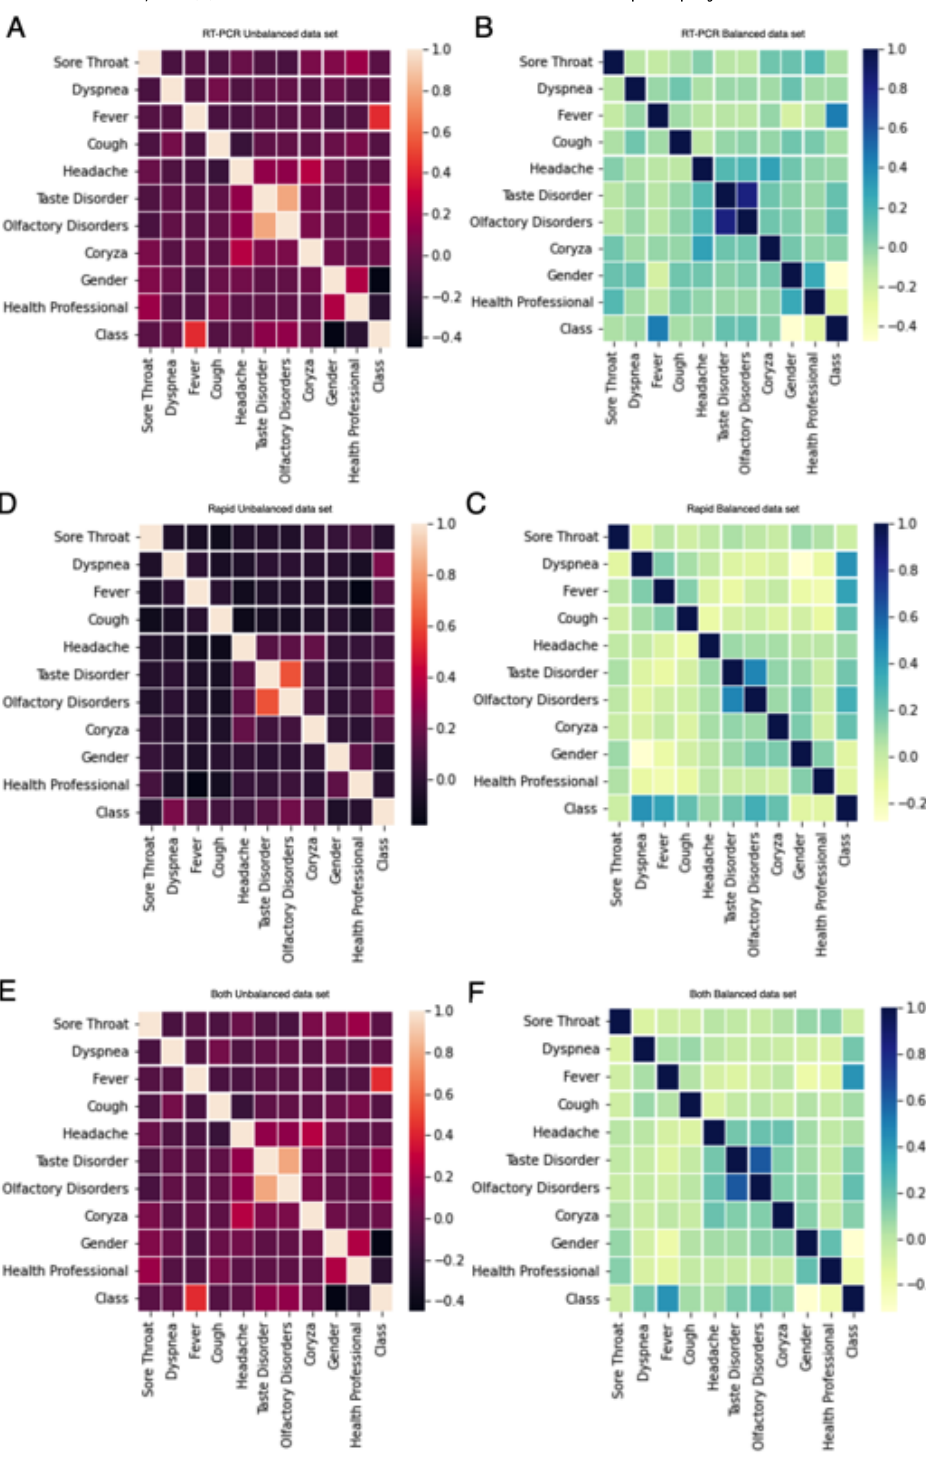
Figure 2. Correlation matrix for (A) RT-PCR unbalanced data set, (B) RT-PCR balanced data set, (C) rapid unbalanced data set, (D) rapid